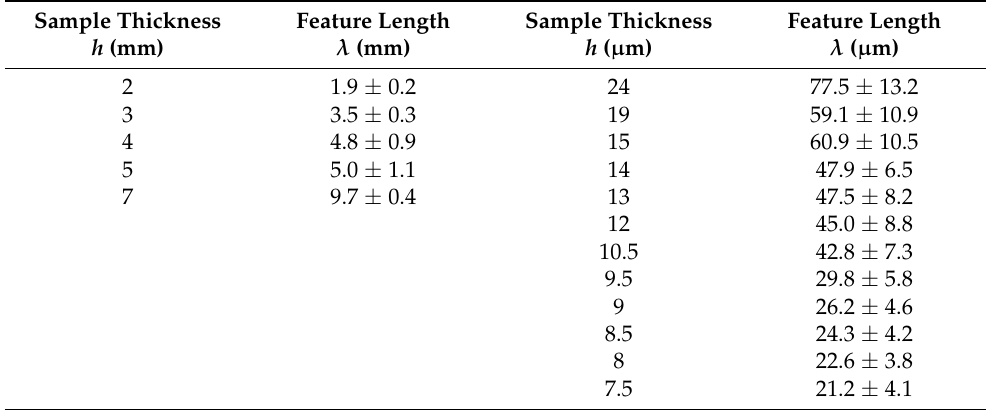
Table A1. The characteristic feature size ( λ ) for different samples thicknesses ( h